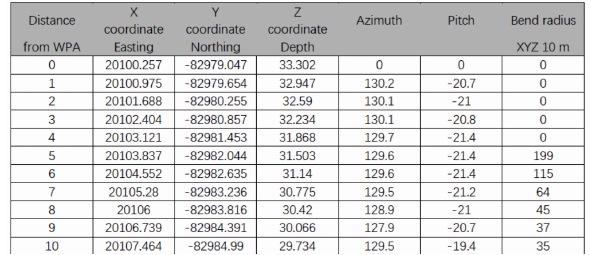
Figure 5. An example of gyroscopic mapping